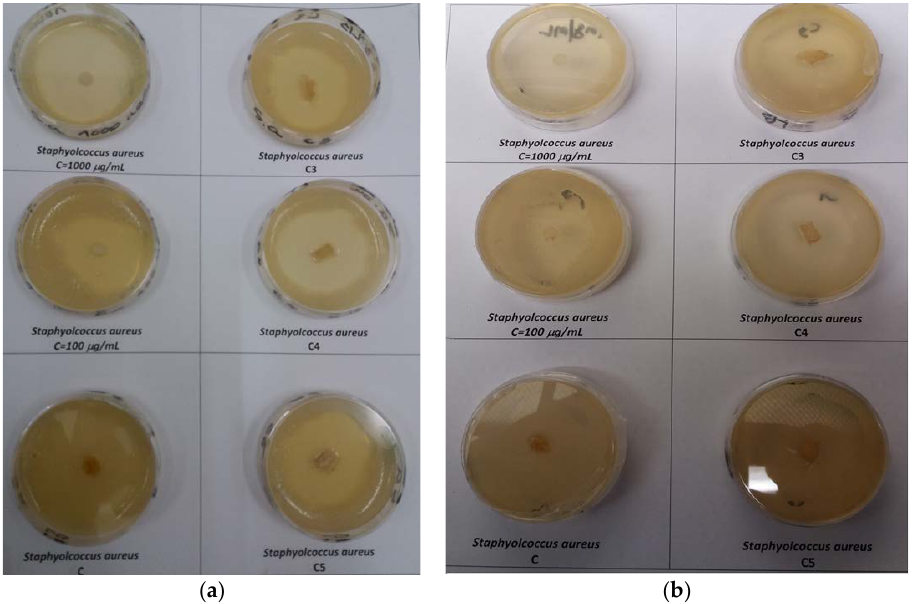
Figure 4. The effect of ciprofloxacin - collagen-based materials on Staphylococcus Aureus . ( a ) frontal Figure 4. The e ff ect of ciprofloxacin-collagen-based materials on Staphylococcus Aureus . ( a ) frontal view view and ( b ) dorsal view—for sample code see Table 2 . and ( b ) dorsal view—for sample code see Table 2.